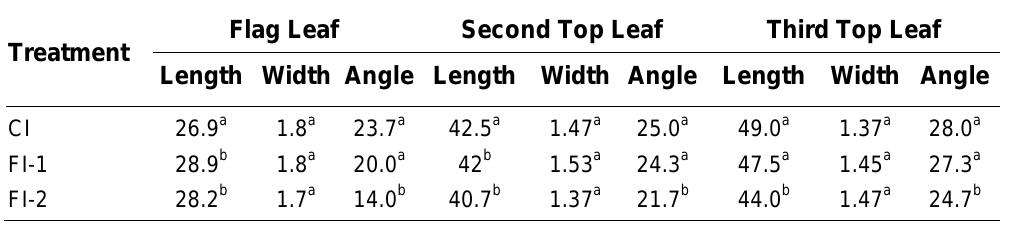
Biological Parameters for Top Three Leaves in the CI, FI-1, and FI-2 Treatments Conducted at Guandong Ocean University Experiment Station in 2002